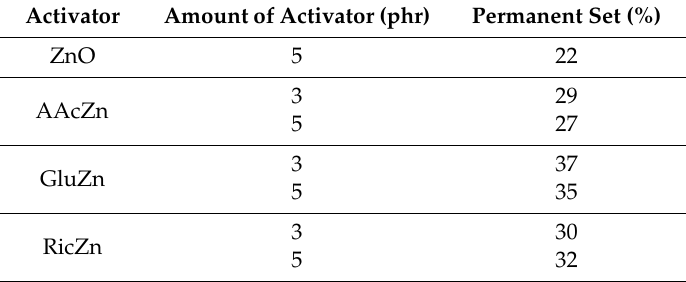
Table 5. Permanent set of SBR vulcanizates (standard deviation ±